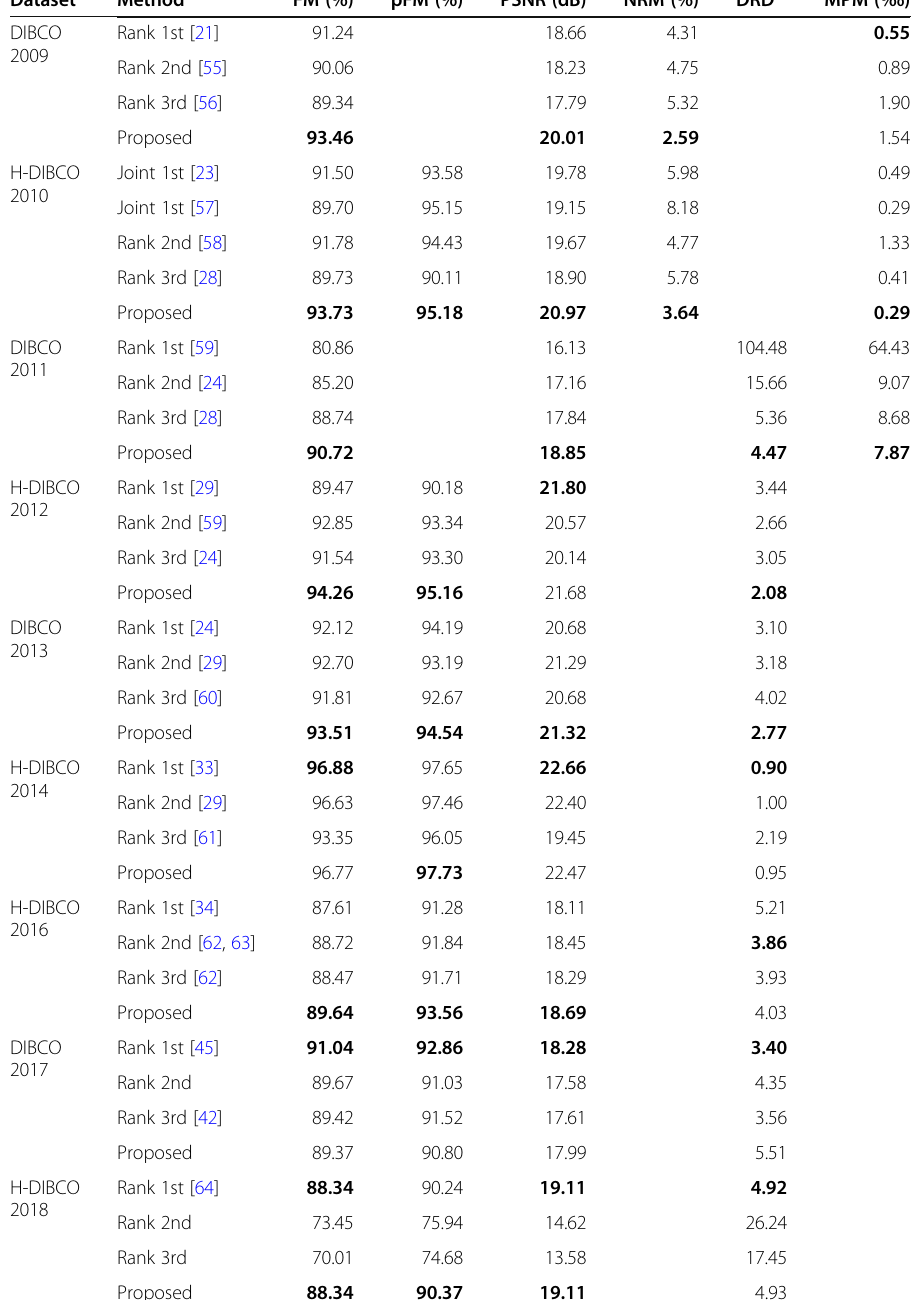
Table 1 Performance evaluation results of our proposed method against the TOP 3 winners of the annual DIBCO or H-DIBCO competitions (best results highlighted in bold)